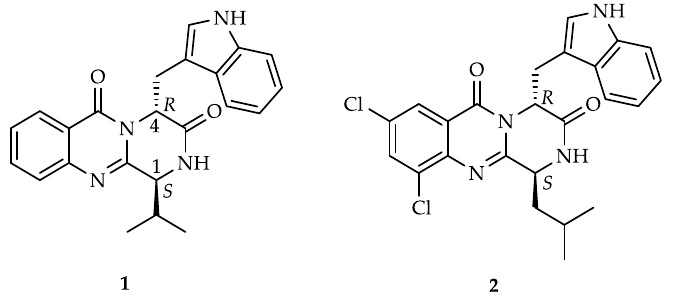
Figure 1. Structures of target compounds for gram syntheses, (1 S ,4 R )-4-(1 H -Indol-3-ylmethyl)-1- isopropyl-2 H -pyrazino[2,1- b ]quinazoline-3,6(4 H )-dione (fiscalin B) ( 1 ) and (1 S ,4 R )-4-[(1 H -indol-3- yl)methyl]-8,10-dichloro-1-isobutyl-1,2-dihydro-6 H -pyrazino[2,1- b ]quinazoline-3,6(4 H )-dione ( 2